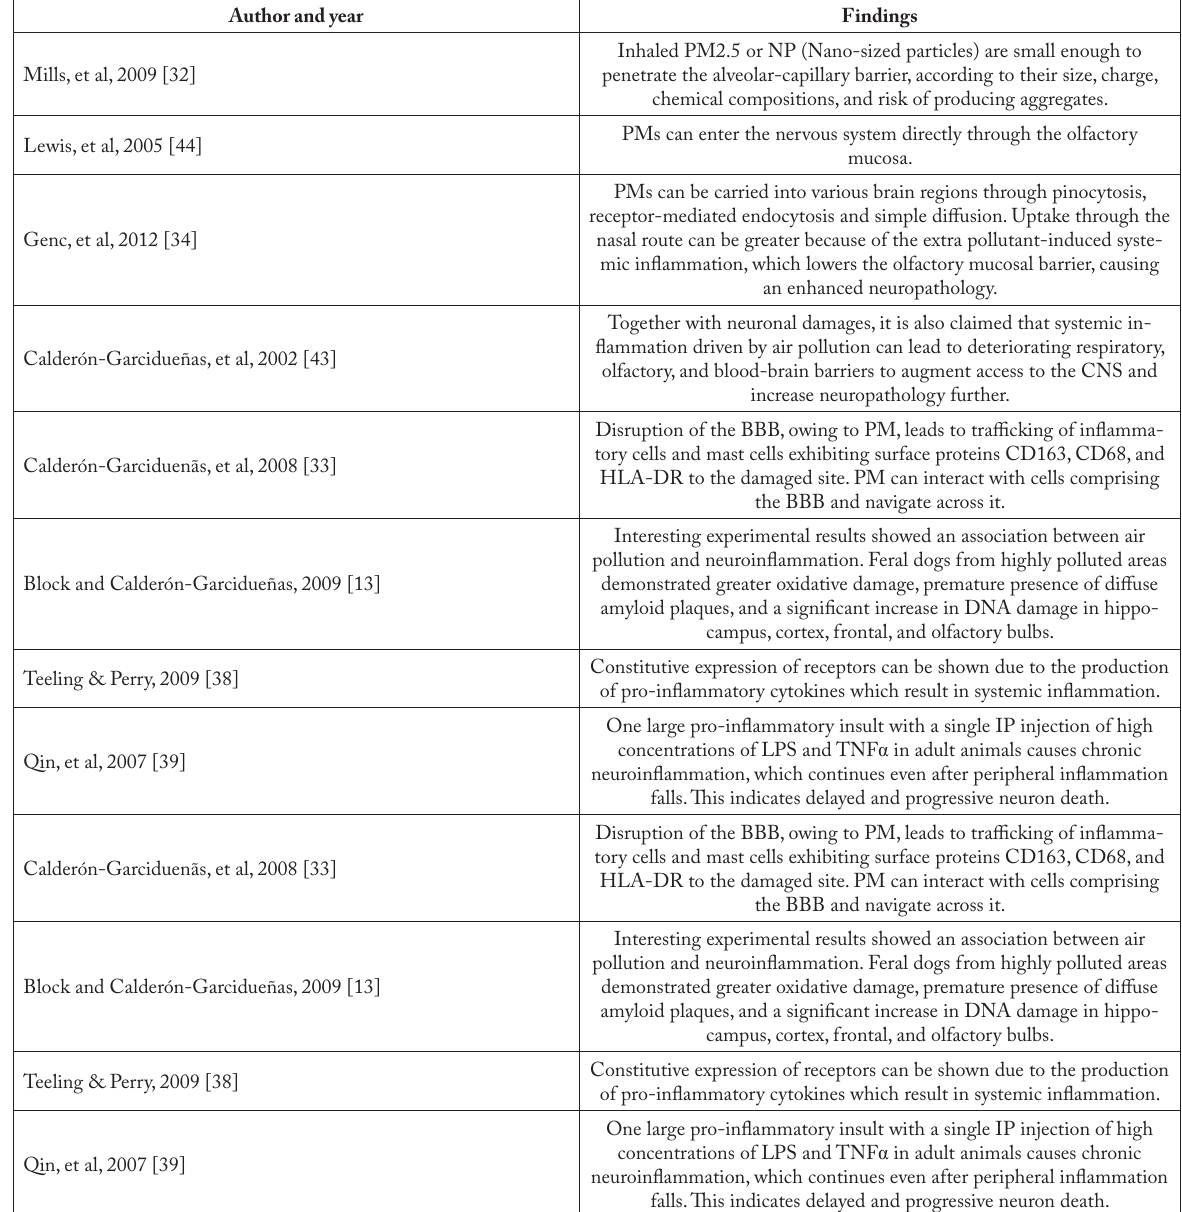
Table 1. Main studies about correlation between air pollution, neuroinflammation and Alzheimer’s disease.